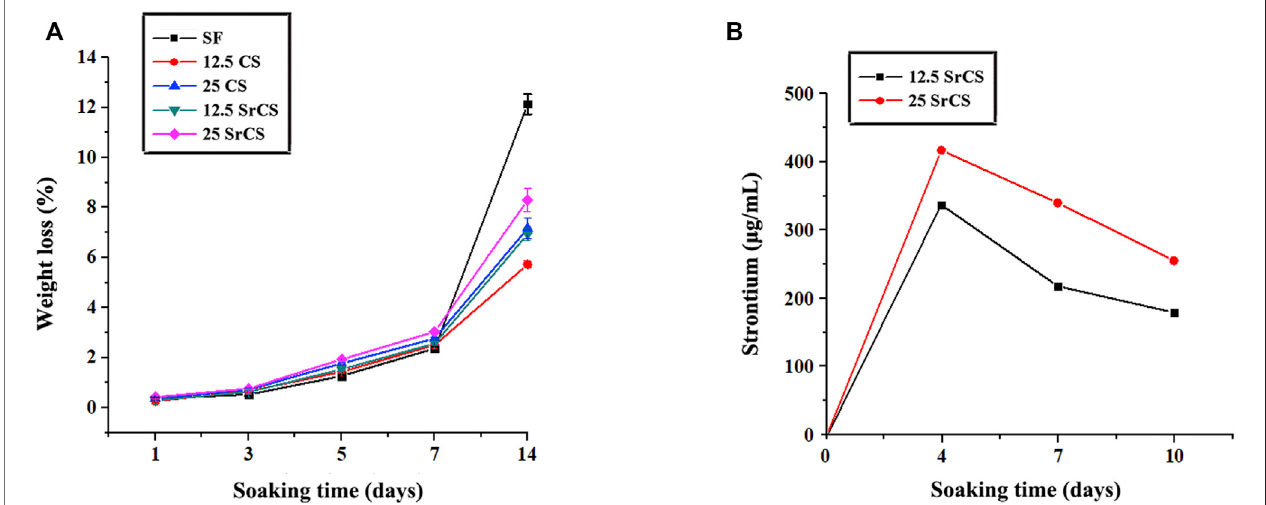
FIGURE3| Degradationandionreleasepropertiesofmaterials. (A) Degradationbehaviorofmaterials. (B) Strontiumreleasecurveof12.5 wt%and25 wt%SrCS/ SF scaffold materials. (SF: SF, 12.5 CS: 12.5 wt% CS/SF, 25 CS: 25 wt% CS/SF, 12.5 SrCS: 12.5 wt% SrCS/SF, 25 SrCS: 25 wt% SrCS/SF).